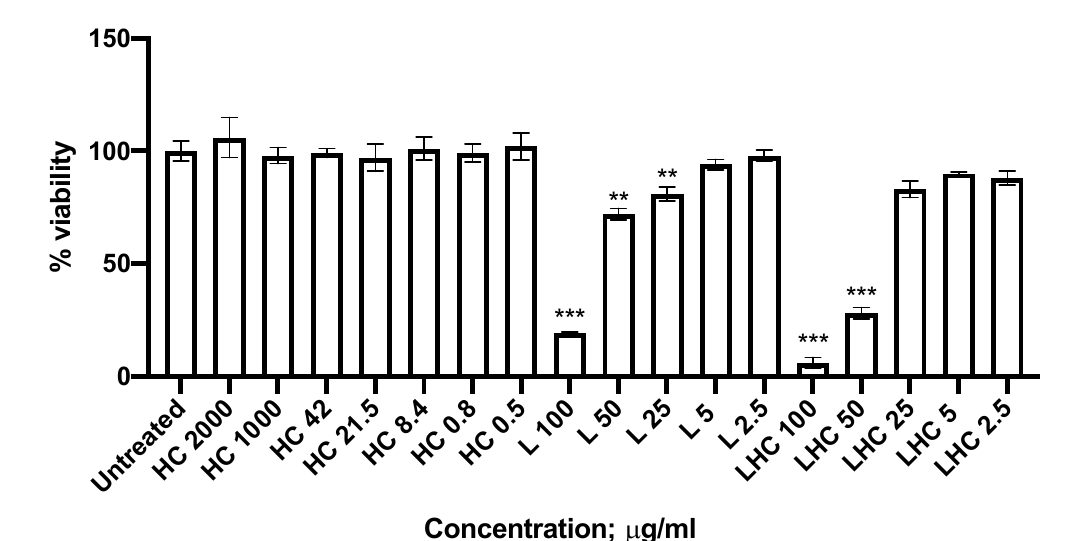
Figure 4. Cytotoxic activity on MRC-5 human fibroblast cells after 24 h treatment with HC, L and LHC. Evaluation was performed by means of MTT assay. Data are the mean % of three independent experiments ± SD. ** p < 0.01 and *** p < 0.001